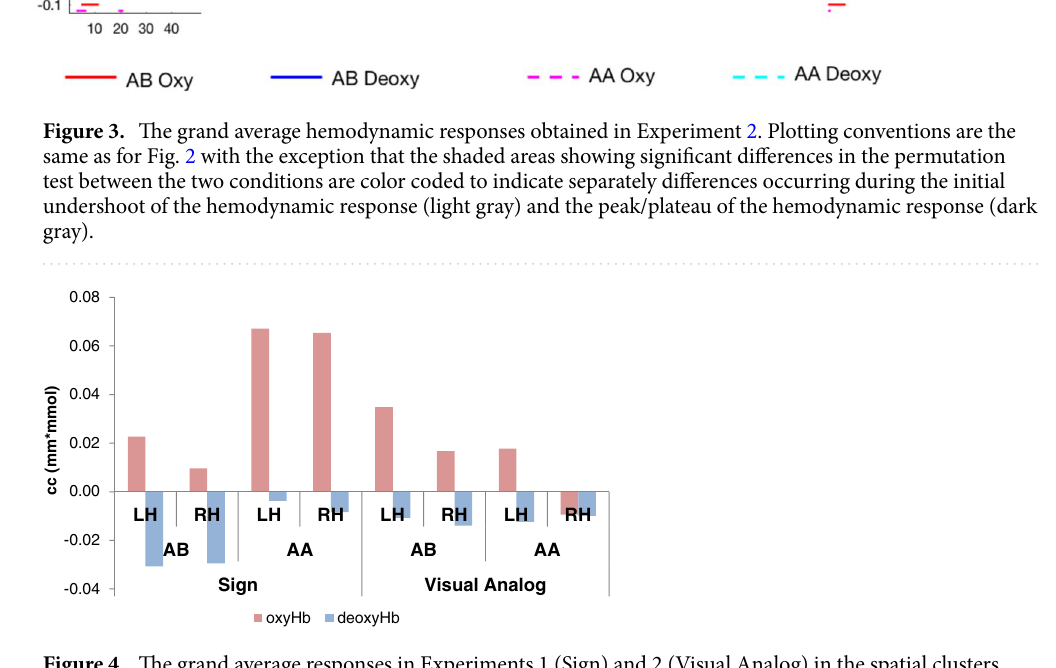
Figure 4. The grand average responses in Experiments 1 (Sign) and 2 (Visual Analog) in the spatial clusters identified by the permutation